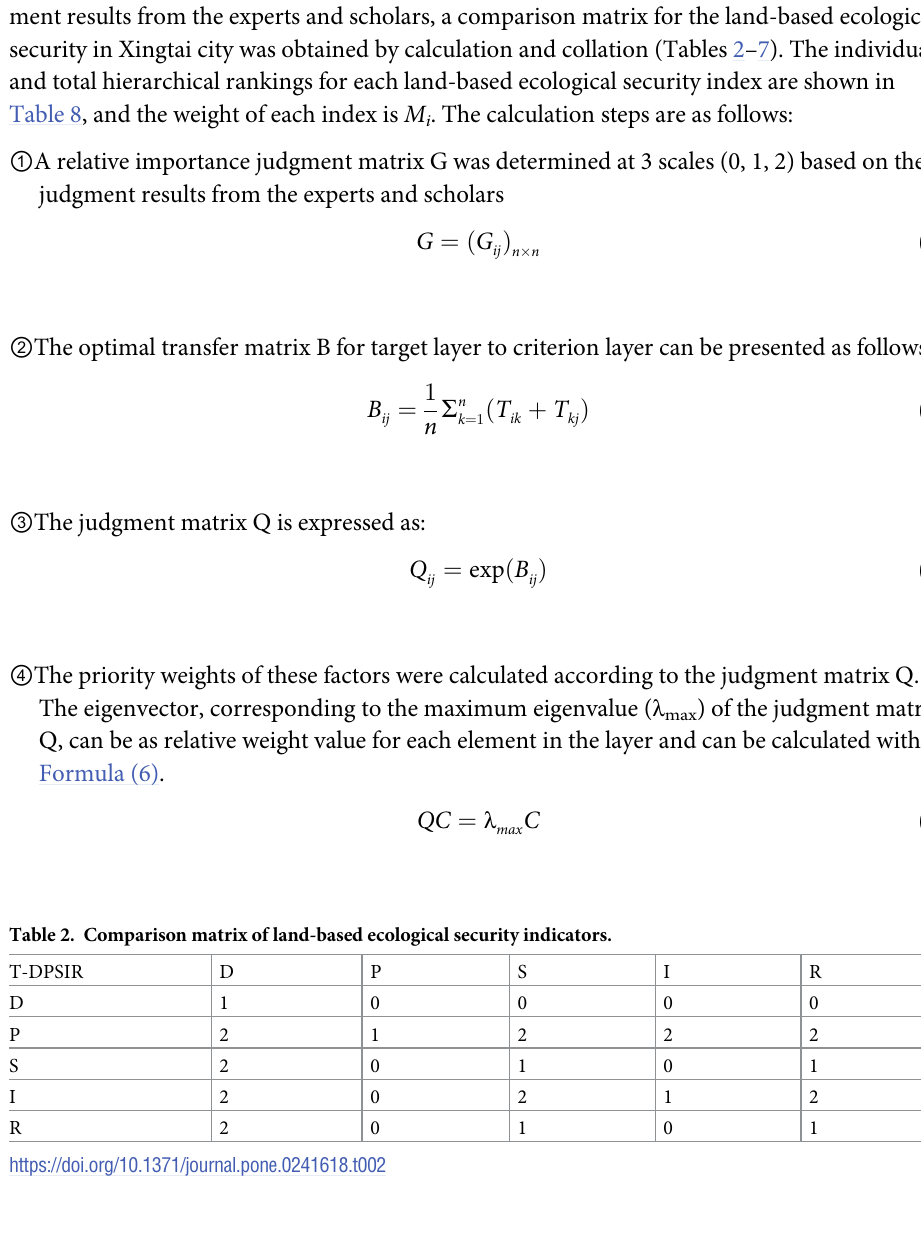
Table 3. Comparison matrix of driving